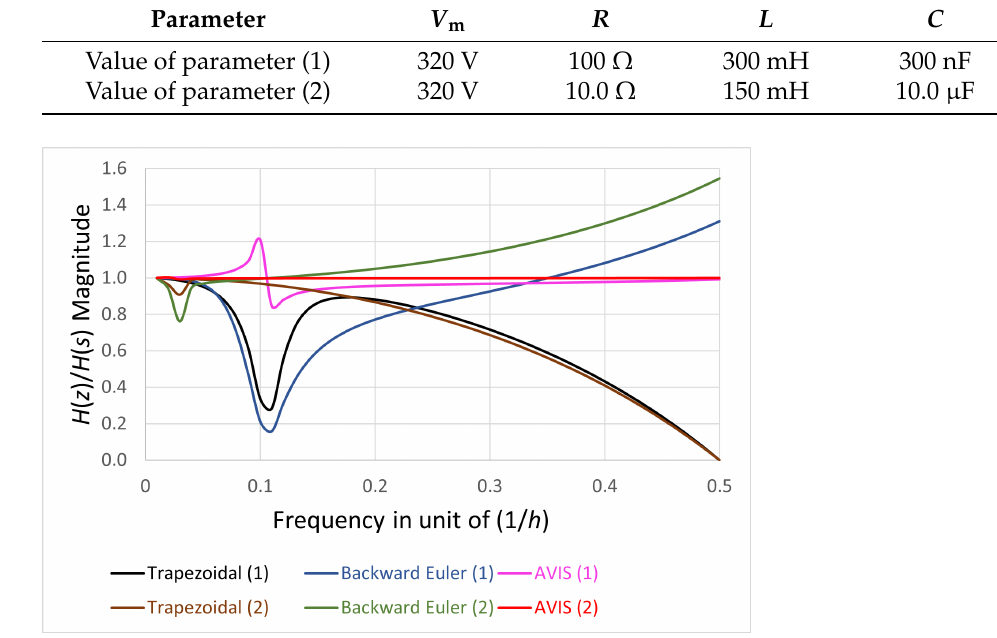
Figure 4. Magnitude ratio of the frequency response of the integration rules ( h = 0.2 ms).